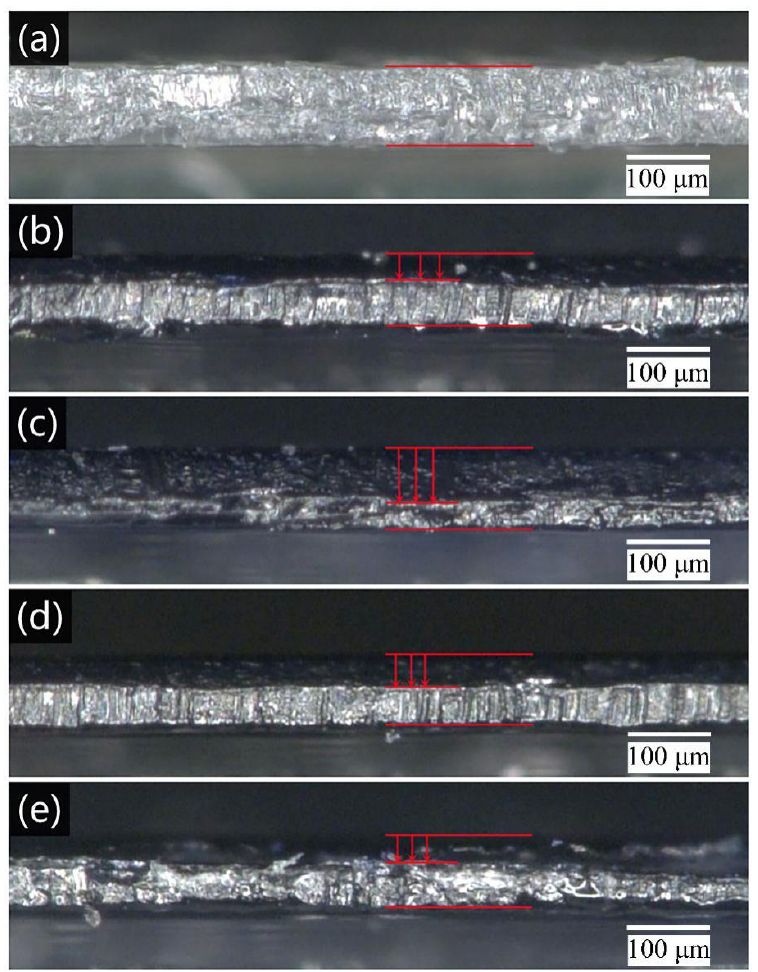
Figure 3. Cross-section images of printed PET films: ( a ) pure PET film, ( b ) PET film printed with PVP ink, ( c ) PET film printed with PVA in, ( d ) PET film printed with PEG ink, and ( e ) PET film printed with control sample.